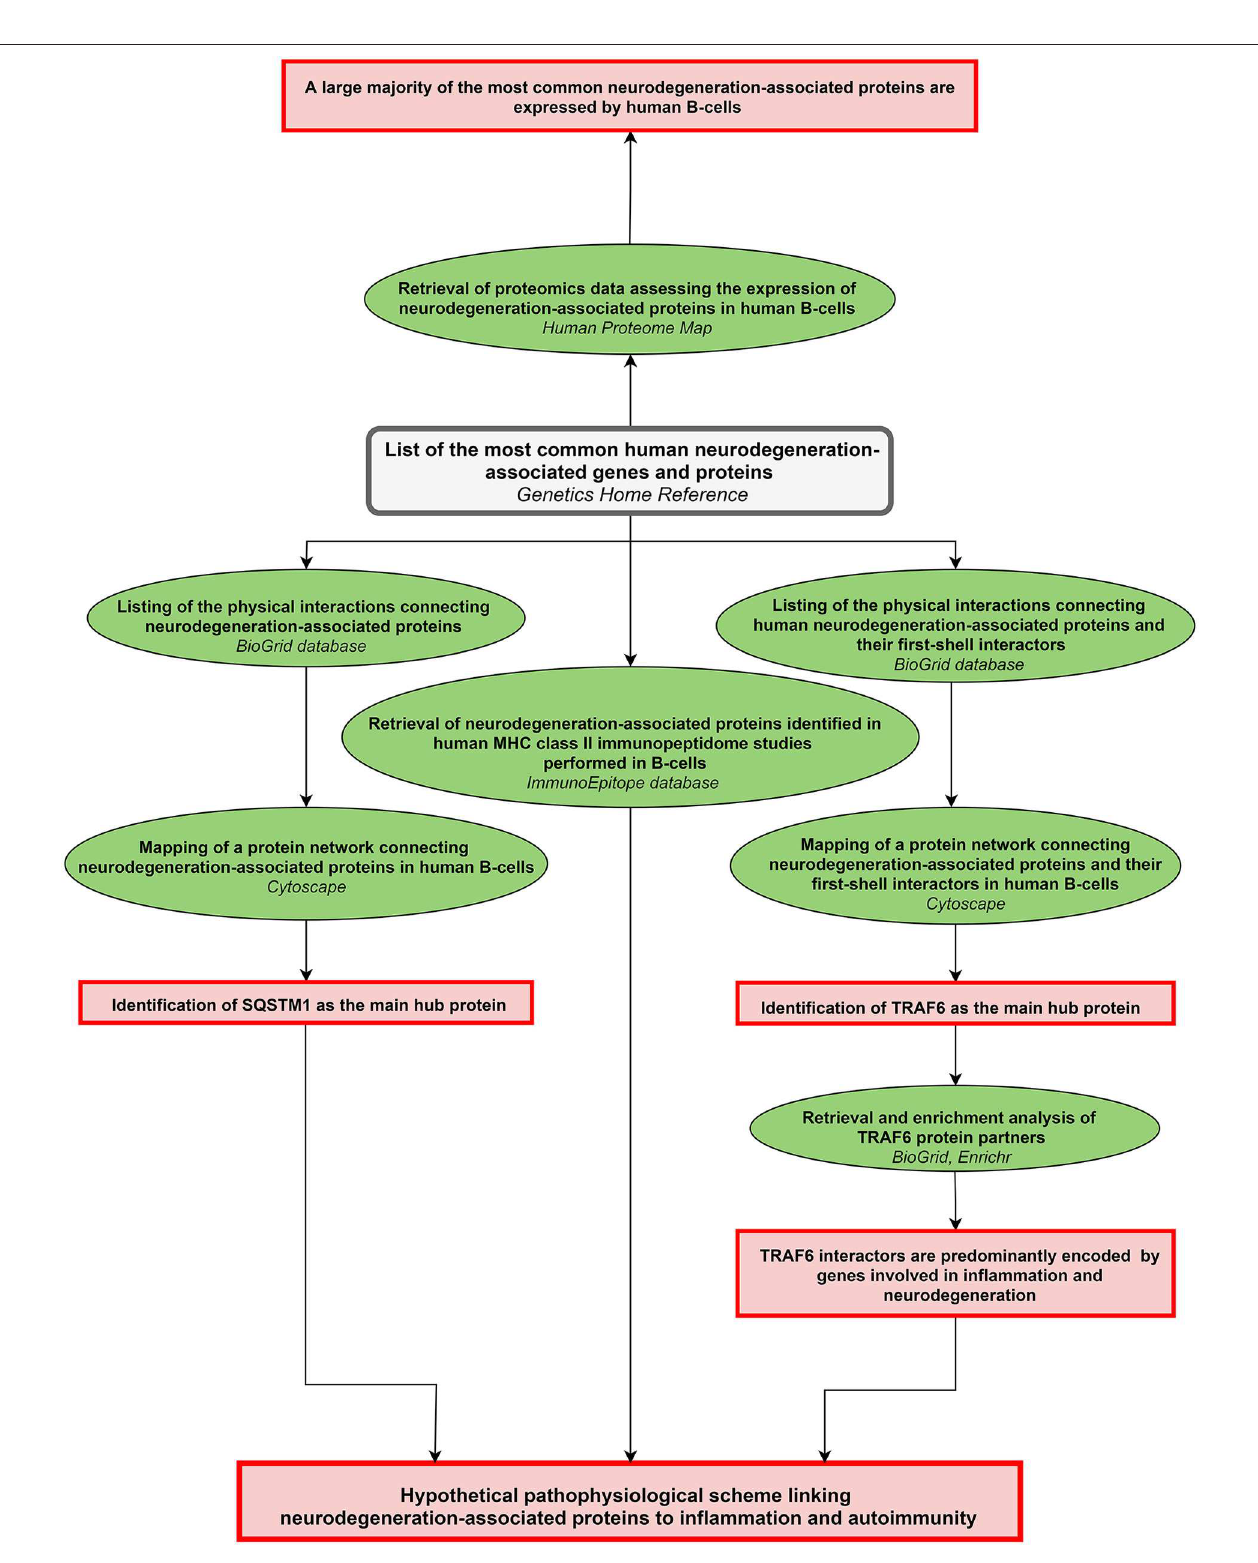
FIGURE 1 | Workflow of the study. The workflow starts from the upper central gray rectangle. Other rectangles (in red) frame the main results obtained following each of the analytical steps which are briefly described in green ellipse shapes. Terms in italics correspond to the name of the bioinformatics tools used for each analytical step. MHC: major histocompatibility